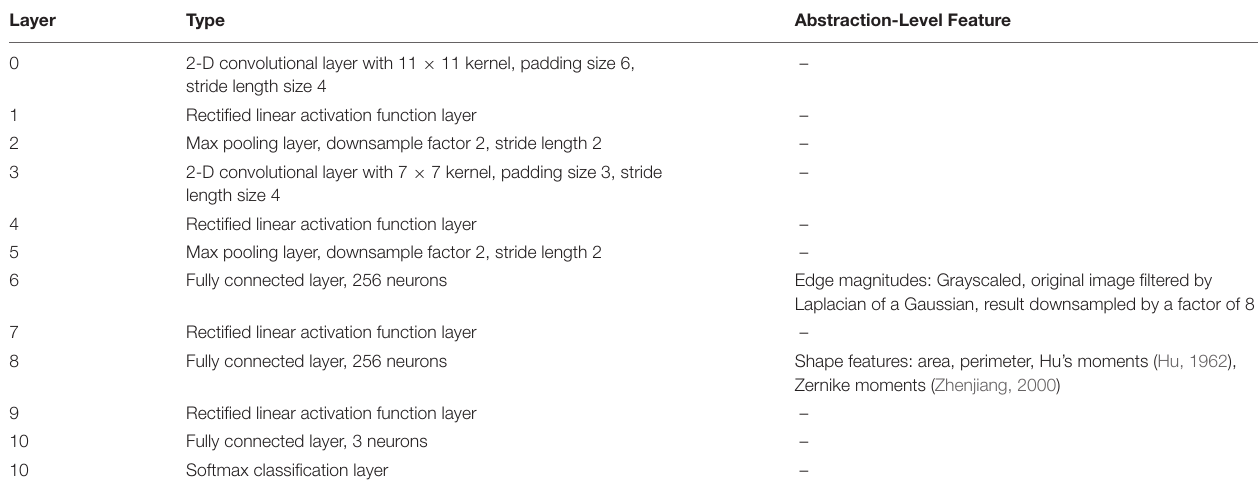
TABLE 1 | Structure of the convolutional neural network employed in this work.